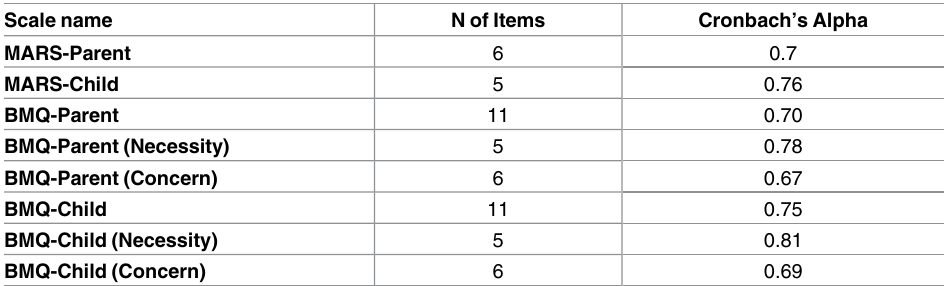
Table 3. Reliability